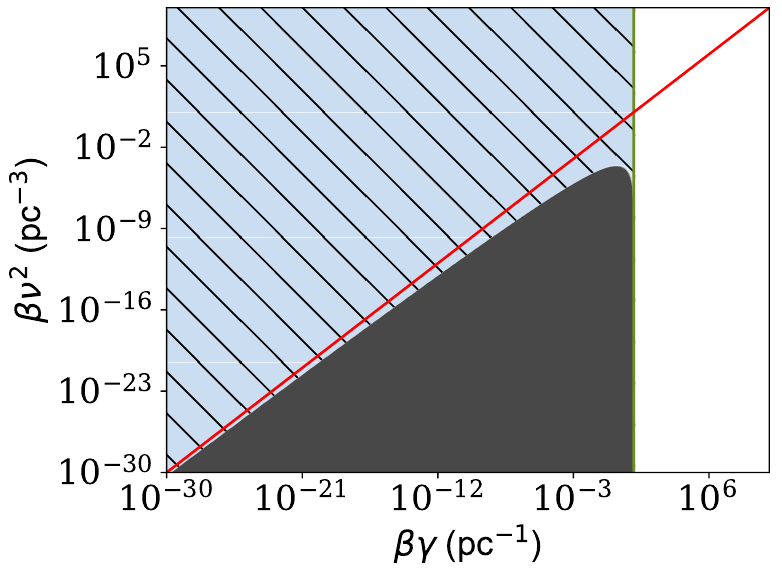
Figure 4. Bounds on the coefficients of the free energy expansion at 5% significance level using ∆ > 100 (pc) of Figure 3. The vertical line is at βγ = 10 ( pc − 1 ) and the diagonal red line shows βγ = βν 2 . The solid gray region is excluded for DM models that live far from their critical temperature. An example is a dark classic gas. The solid grey region and the hatched blue region, i.e., the entire region left to the vertical line, are excluded for DM models that live close to their critical temperature. Superfluid models of DM for example. In any model of DM, there is a map between γ and ν 2 parameters and the underlying principles of the model. Therefore, this plot can be used to explore the allowed regions of the parameter space of DM